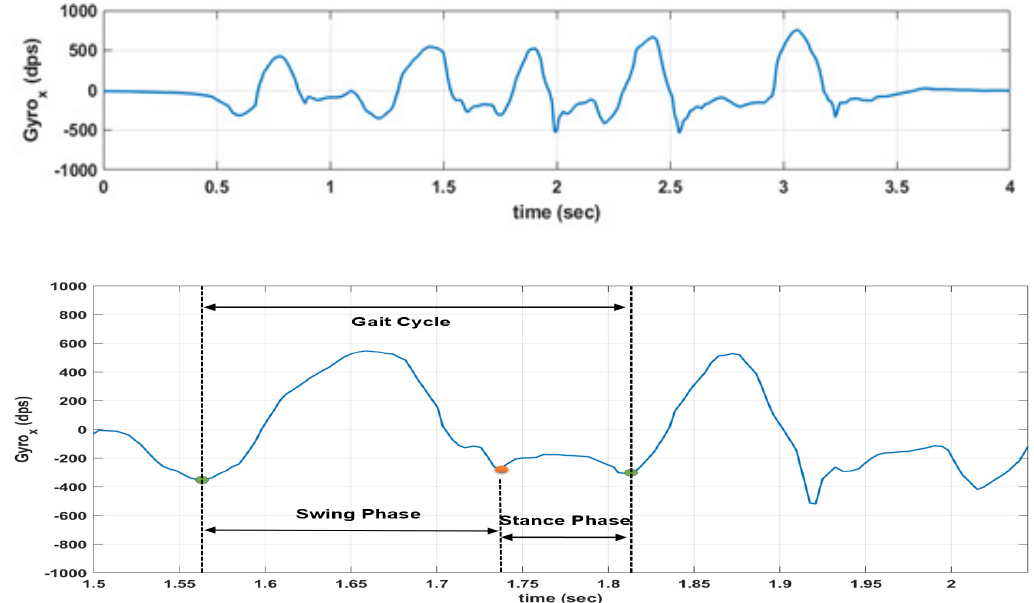
Figure 3. Example of raw inertial data (angular rate over the sagittal axis) collected for one repetition from a sensor on the shank, and the definition of gait cycle, stance and swing phases. Stance phase, swing phase, and gait cycle are marked with dotted lines.